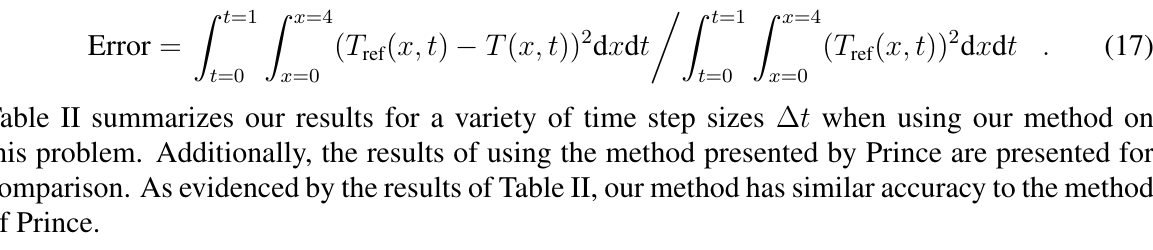
Table II. Error compared to reference